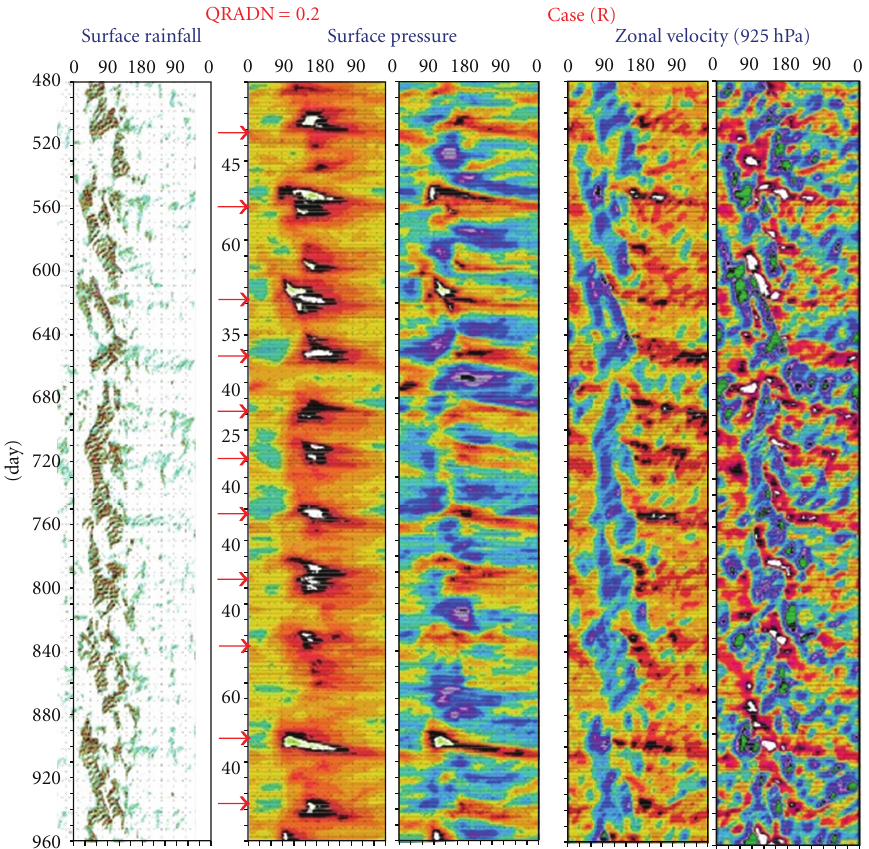
Figure 6: Same as Figure 2 but for case